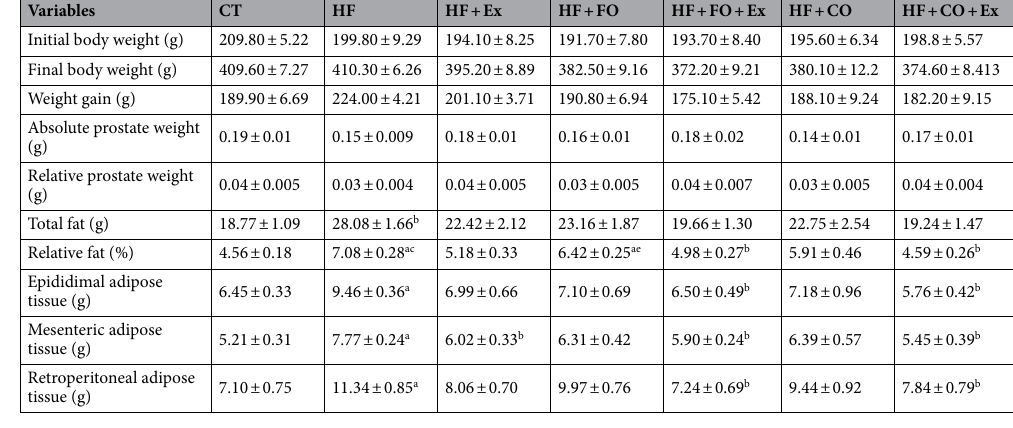
Table 1. Data on initial and final body weight, weight gain, absolute and relative prostate weights, absolute and relative fats, epididimal. mesenteric and retroperitoneal adipose tissues of trained animals, fish and chia oil intake, submitted to high-fat diet for 14 weeks. Data are presented as the mean ± SEM (n = 7). The significance of p < 0.05 is indicated by lowercase letters indicating a difference between the groups. a Referring to the control group. b Referring to the high-fat diet group. c Referring to a diet rich in fat + ω-3 group. d Referring to a high-fat diet + physical exercise group. e Referring to a diet rich in fat + ω-3 + aerobic physical exercise group. f Referring to a high-fat diet + chia group. g Referring to high-fat diet + chia + physical exercise group. The Two-Way ANOVA test was used to compare the means. with the Tukey